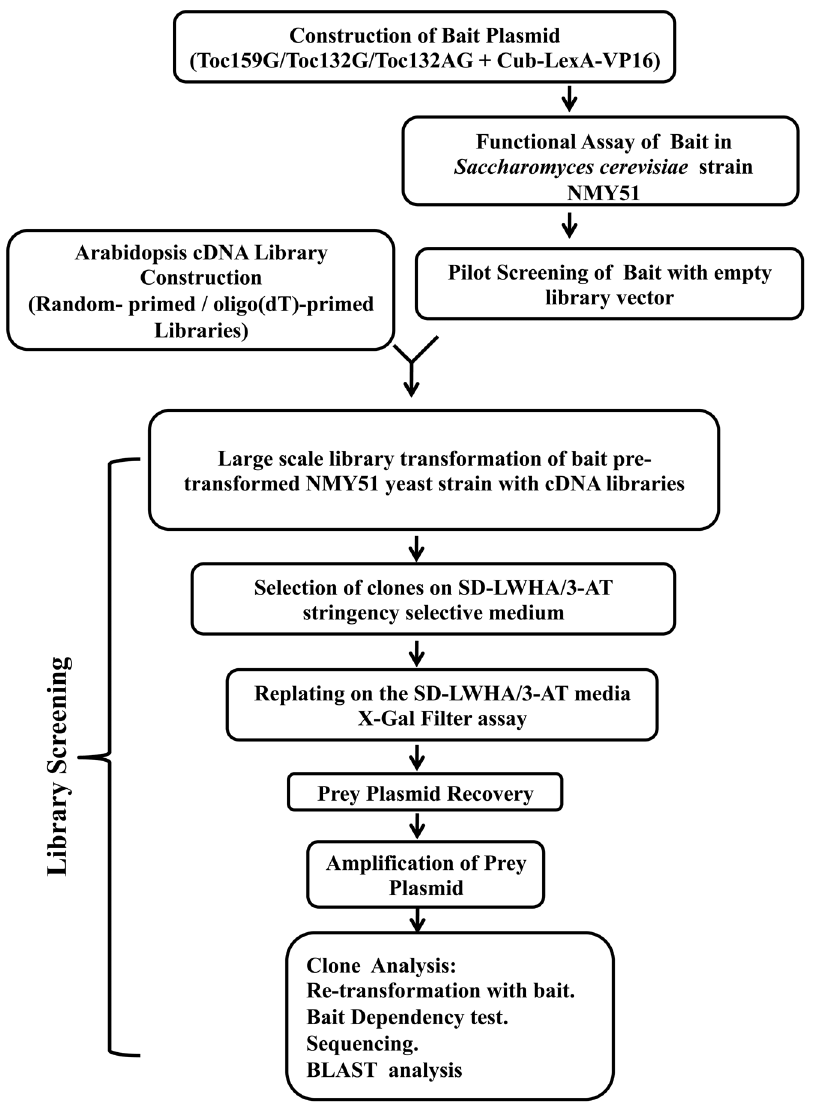
Figure 2. Flow chart outlining the protocol used for split-ubiquitin-based screening of an Arabidopsis cDNA library for interactors of atToc159G, atToc132G and atToc132AG baits. S. cerevisiae strain NMY51 was transformed with Toc159G, Toc132G or Toc132AG bait constructs and a split-ubiquitin yeast two-hybrid assay was performed utilizing positive, negative and empty prey plasmids. Optimization of the screening stringency was achieved through pilot screening, which involved large scale transformation of bait pre-transformed yeast with empty library vector. Selection of positive clones was conducted on the quadruple dropout media supplemented with 3-aminotrizole. The colonies that grew on the selective media were re-plated on the same stringent selective medium. Prey plasmids were re-isolated from the putative positive clones. Two degrees of selection (i.e. individual retransformation with respective baits and bait dependency test) were followed by sequencing and BLAST analysis to confirm the interactions and simultaneously identify the